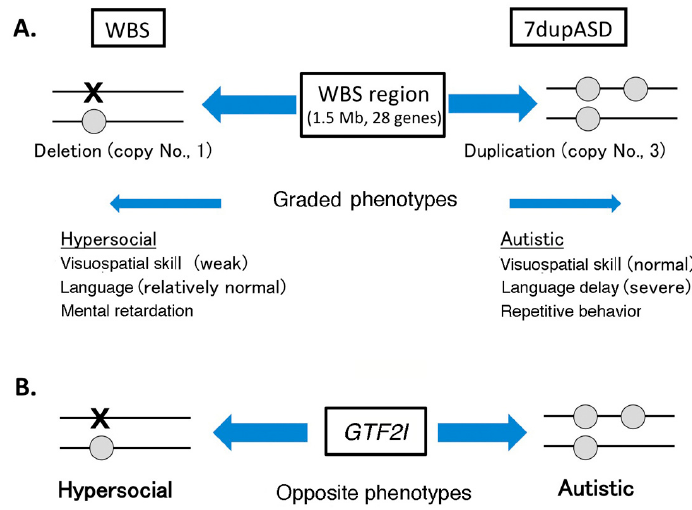
Figure 2. Psychiatric phenotypes dependent on copy number variations (CNV) of the Williams–Beuren syndrome (WBS) region and GTF2I . ( A ) Effects of CNV on the WBS region; ( B ) Effects of CNV on GTF2I . Characteristic features of WBS and 7dupASD are listed. Gray circles indicate presence of a single copy of the GTF2I and X indicates the absence of the gene.